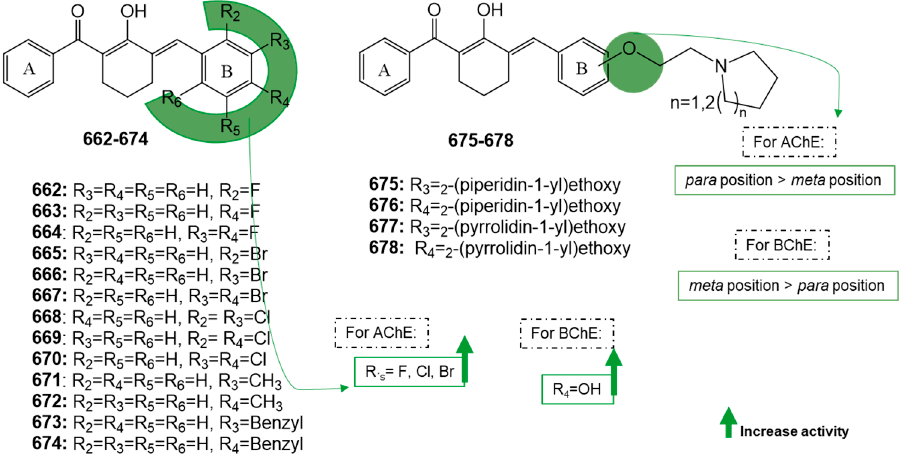
Figure 17. Diarylpentanoids as promising neuroprotector agents.